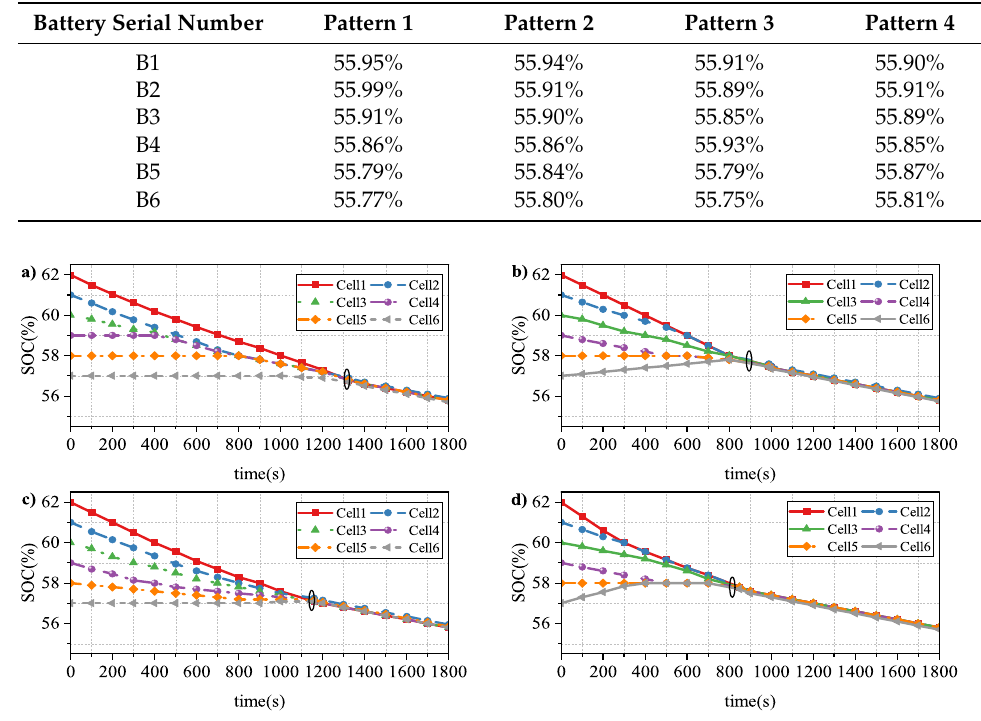
Figure 12. Equalization process of the four circuits in the discharged state: ( a ) Pattern 1; ( b ) Pattern 2; ( c ) Pattern 3; and ( d ) Pattern 4.